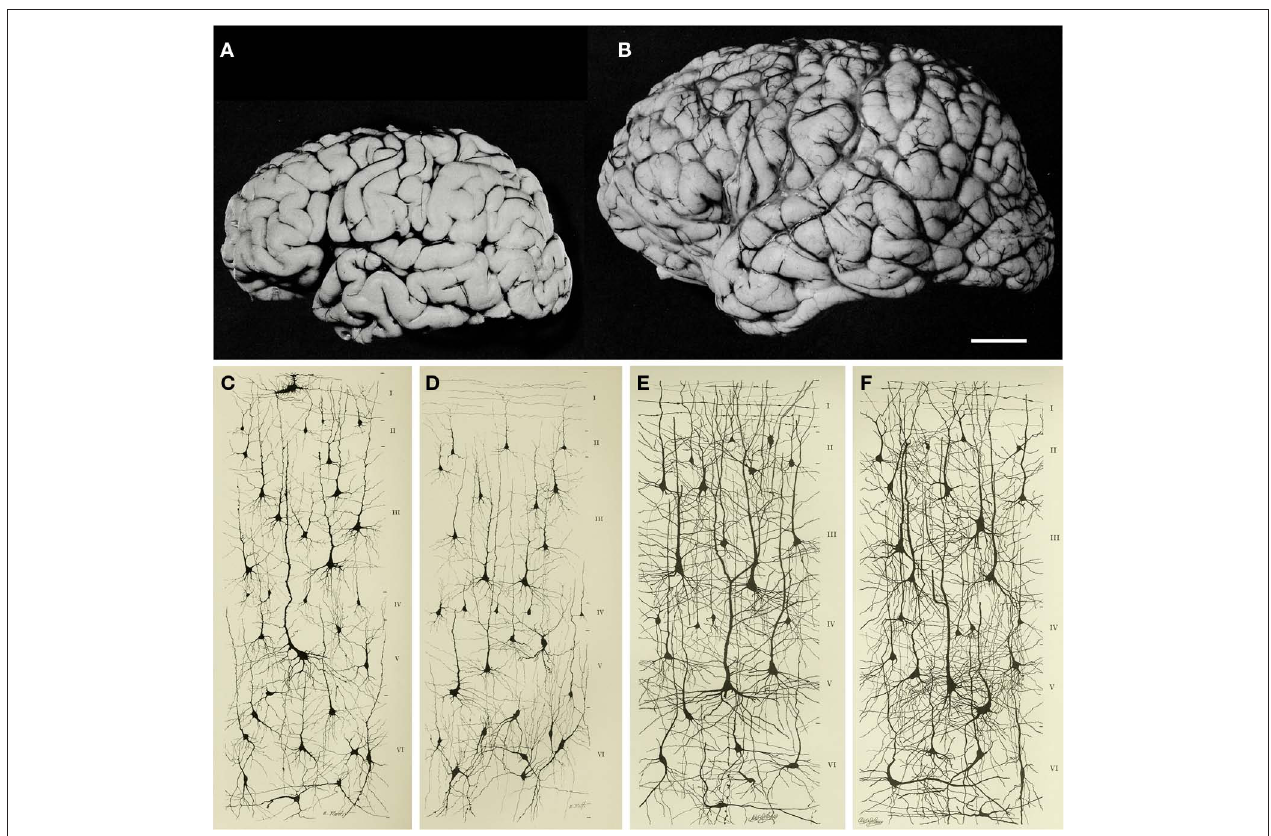
background and the environment. This increase in the complexity is clearly evident in the drawings of Golgi stained cortical neurons from the cerebral cortex of a 1-month [ (C) “pars triangularis of gyrus frontalis inferior”; (D) “orbital gyrus”] and 6 year [ (e) , “pars triangularis of gyrus frontalis inferior”; (F) “orbital gyrus”] old child. Adapted from Conel and Le (1941, 1967). Scale bar for (A,B) :